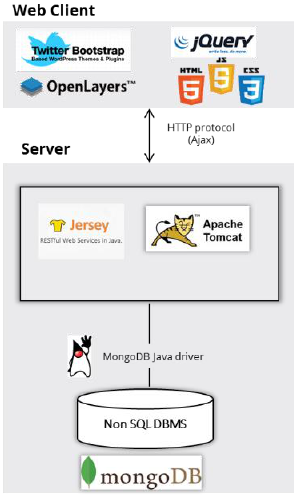
Figure 7. Sensing the city architecture